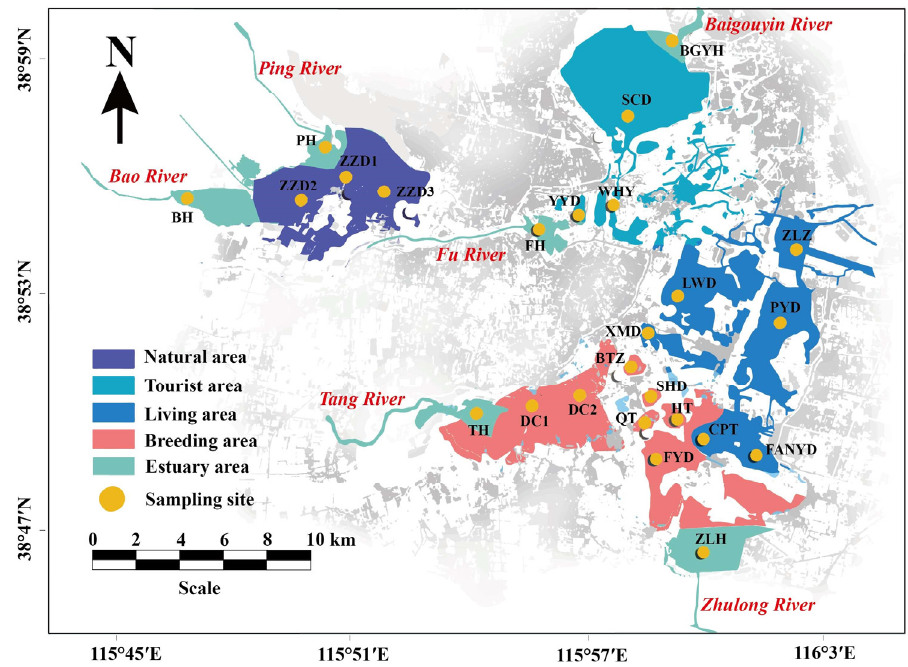
Figure 1. Location of sampling sites in Baiyangdian Lake, Xiongan New Area of China.